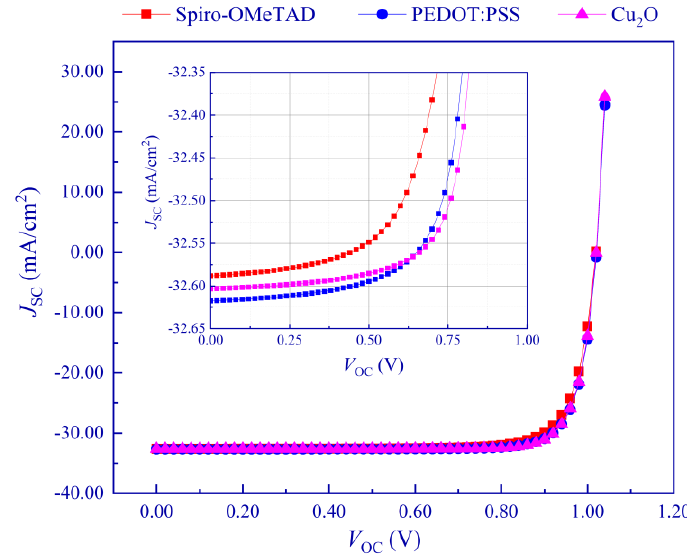
Figure 8. Current-voltage characteristics of perovskite solar cells with different hole-transport layers and a Pt back contact.